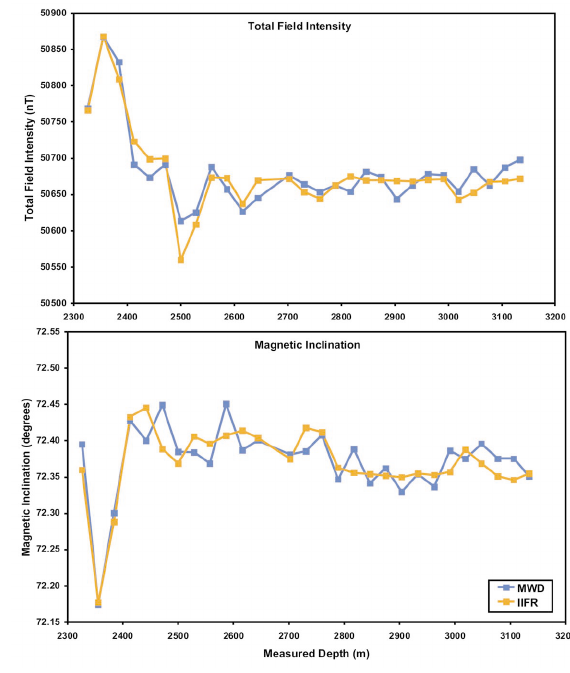
Fig. 5. A comparison of magnetic field values measured by the MWD survey tools (blue) with those calculated by IIFR (orange). Total field intensity is shown at the top and magnetic inclination at the bottom. This survey spans a period of 8 days during 2001.